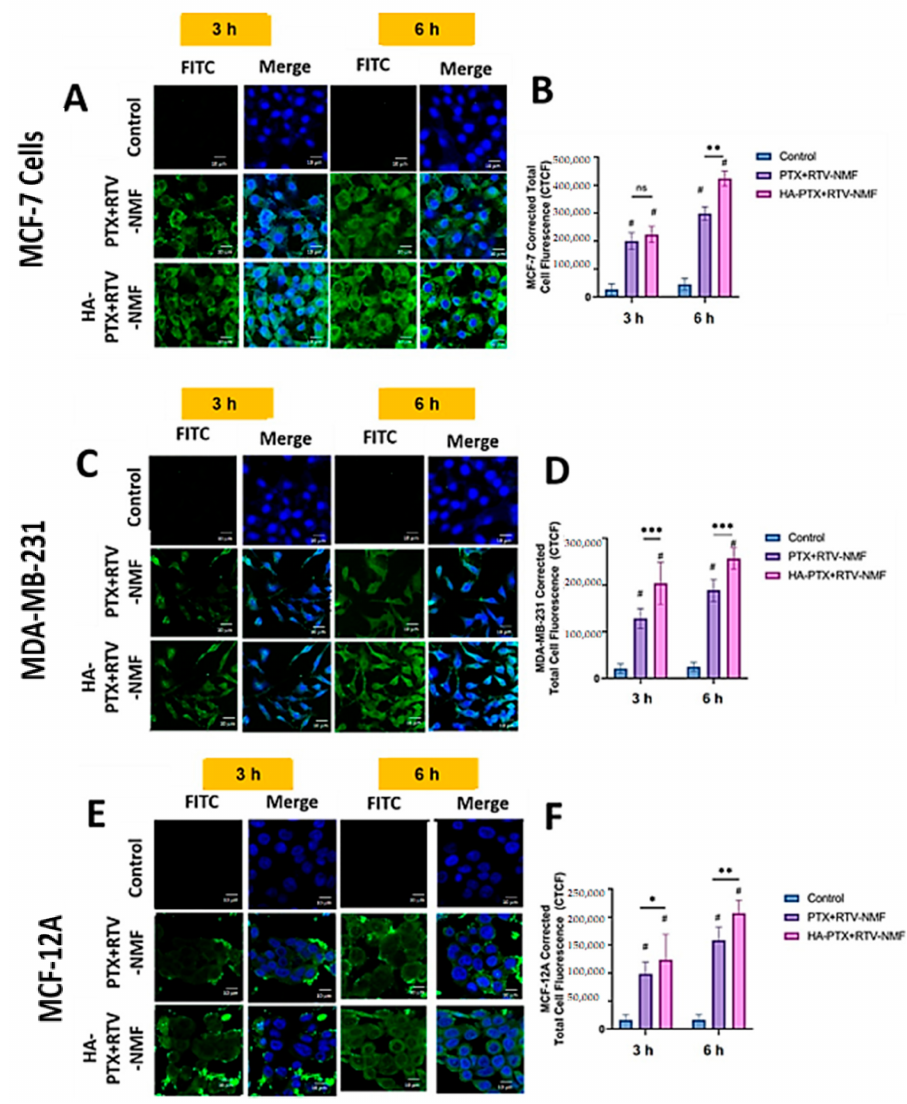
Figure 9. Time-dependent uptake of FITC-labeled HA − PTX + RTV − NMF and FITC-labeled PTX + RTV − NM Fin breast cancer MCF-7 and triple-negative breast cancer, MDA-MB-231, and normal breast epithelium MCF-12A cells. ( A ) Uptake of FITC-labeled HA − PTX + RTV − NMF solution and FITC-labeled PTX + RTV − NMF solution at 6 and 12 h in MCF-7 cells. ( B ) Corrected total cell fluorescence (CTCF) of FITC-labeled HA − PTX + RTV − NMF solution and FITC-labeled PTX + RTV − NMF solution at 6 and 12 h in MCF-7 cells. ( C ) Intracellular distribution of FITC-labeled HA − PTX + RTV − NMF and FITC-labeled PTX + RTV − NMF solution at 6 and 12 h. ( D ) CTCF of FITC-labeled HA − PTX + RTV − NMF solution and FITC-labeled PTX + RTV − NMF solution at 3 and 6 h. ( E ) Intracellular distribution of FITC-labeled HA − PTX + RTV − NMF and FITC-labeled PTX + RTV − NMF solution at 3 and 6 h. ( F ) CTCF of FITC-labeled HA − PTX + RTV − NMF solution and FITC-labeled PTX + RTV − NMF solution at 3 and 6 h. The data were expressed as mean ± SD ( n = 3). (# = significant difference as compared to control group and * p ≤ 0.05, ** p ≤ 0.01, ns = not significant, *** p ≤ 0.001 as compared to PTX + RTV − NMF